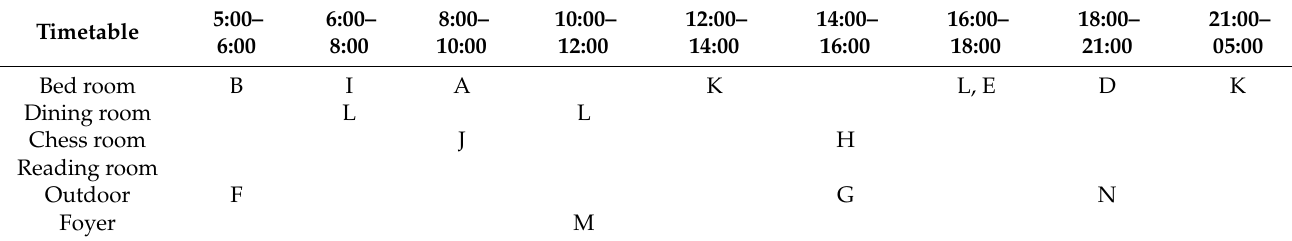
Table 1. The general situation of nursing homes.